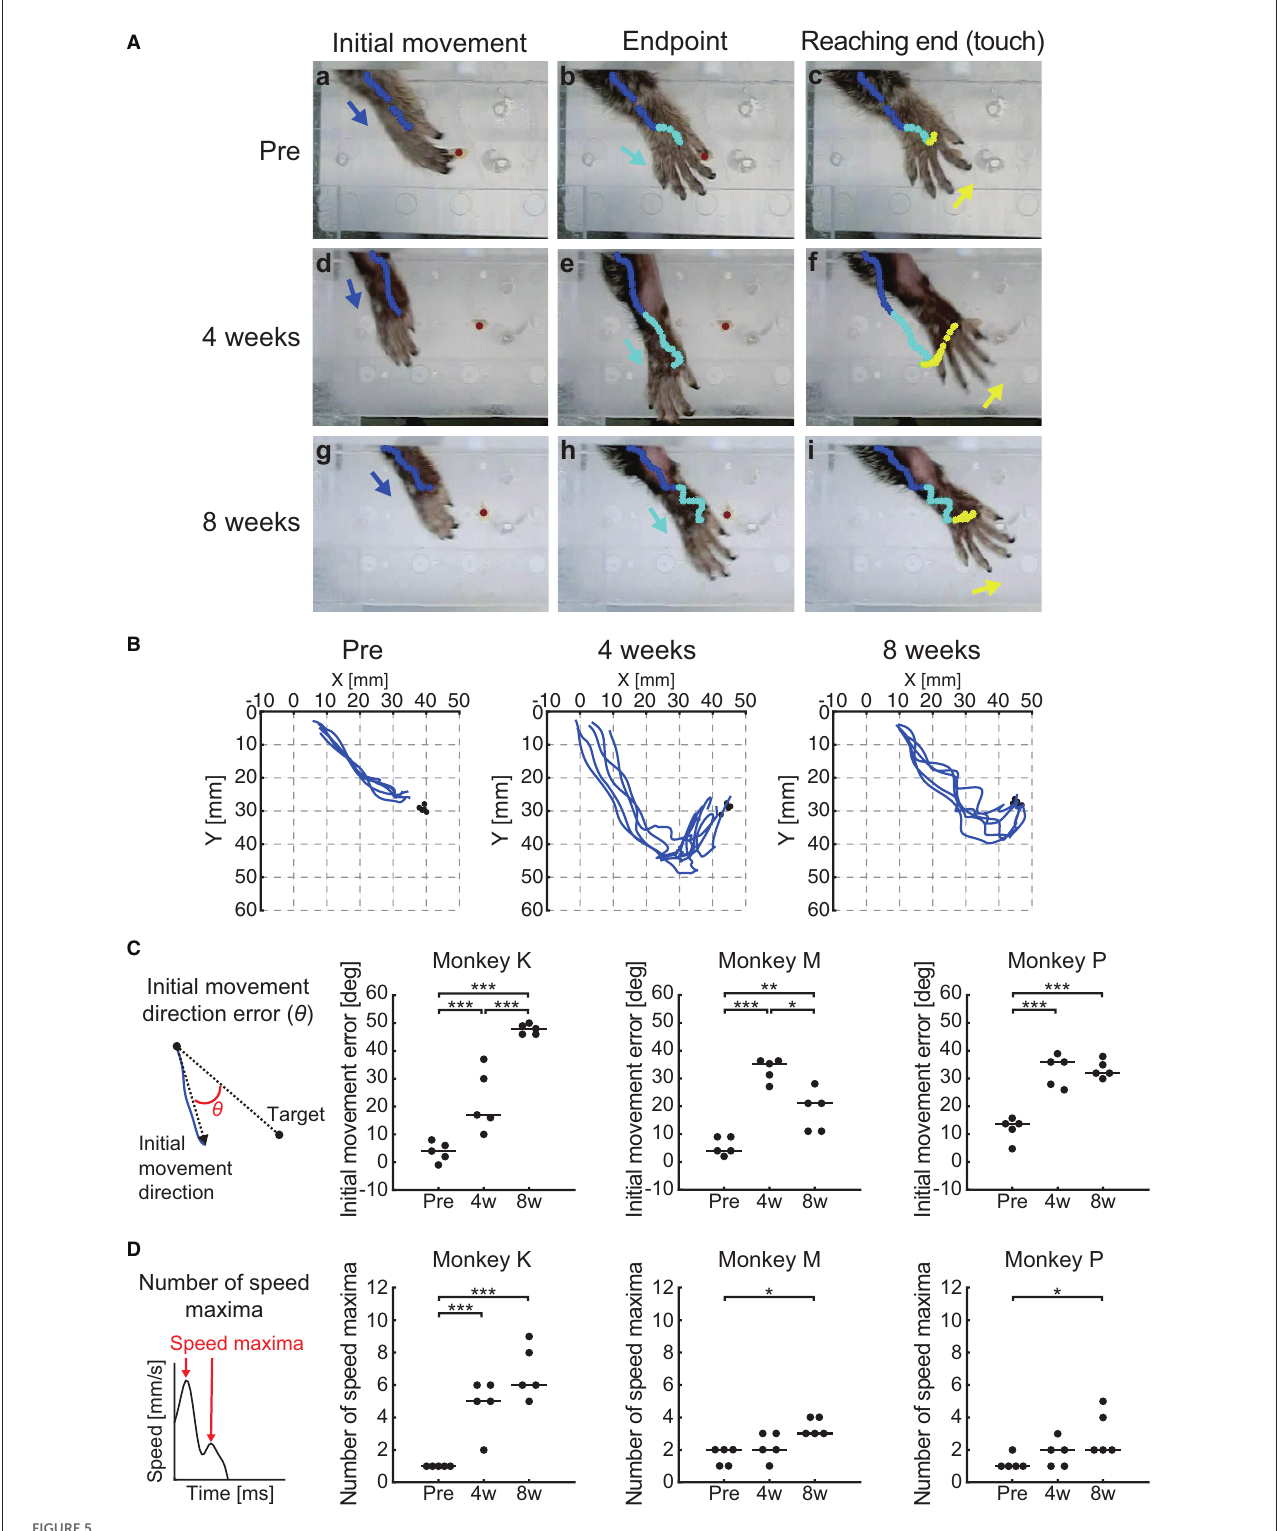
FIGURE5 Behavioral results of reaching function. (A) Representative images of the reaching movement before, 4 weeks, and 8 weeks after creation of the lesion from one representative marmoset (Monkey M). Blue, cyan, and yellow lines indicate the trajectory of the index finger MP joint between movement phases (blue: from “Reaching start” to “Initial movement”; cyan: from “Initial movement” to “Endpoint”; yellow: from “Endpoint” to “Reaching end”). Blue, cyan, and yellow allows indicate movement direction between movement phases. Red circle indicates the position of the food pellet. (B) Typical example of reaching trajectories in the two-dimensional coordinates from one representative marmoset (Monkey M). Black circles indicate the positions at which food pellets were placed. (C) Time course of the transition in the initial movement direction error in each marmoset. Left inset indicates schema of the definition in the initial movement direction error, represented by θ . Black lines indicate median value of each time point. * p < 0.05; ** p < 0.01; *** p < 0.001. (D) Time course of the transition in the number of speed maxima in each marmoset. Left inset indicates schema of the definition in the number of speed maxima. Black lines indicate median value of each time point. * p < 0.05; *** p <